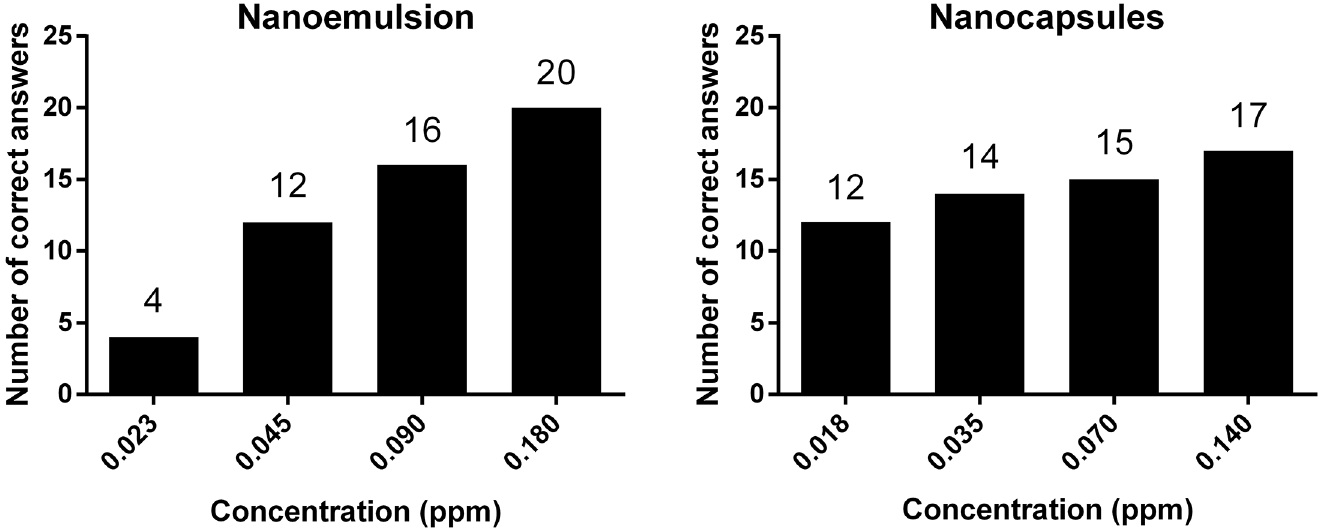
Fig 6. Number of correct answers during best estimate threshold (BET) study. Number of correct answers according to different concentrations of capsaicin for the nanoemulsion and the nanocapsules.